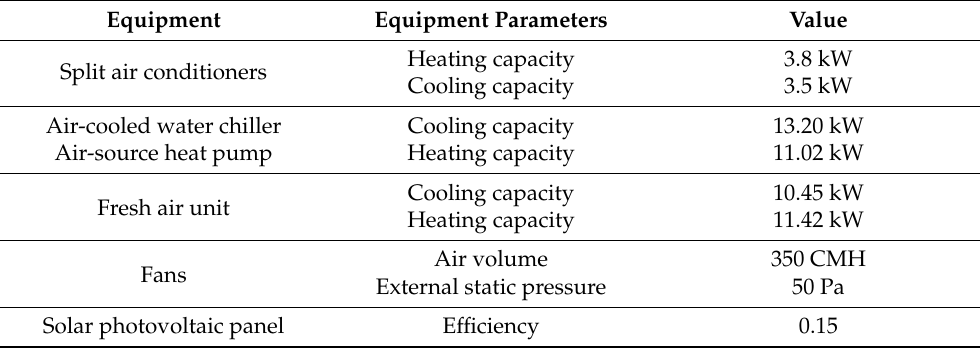
Figure 6. Air-conditioning system model in the exhibition area: ( a ) The whole air-conditioning ( d ) Air Loop. Table 7. Mechanical and equipment